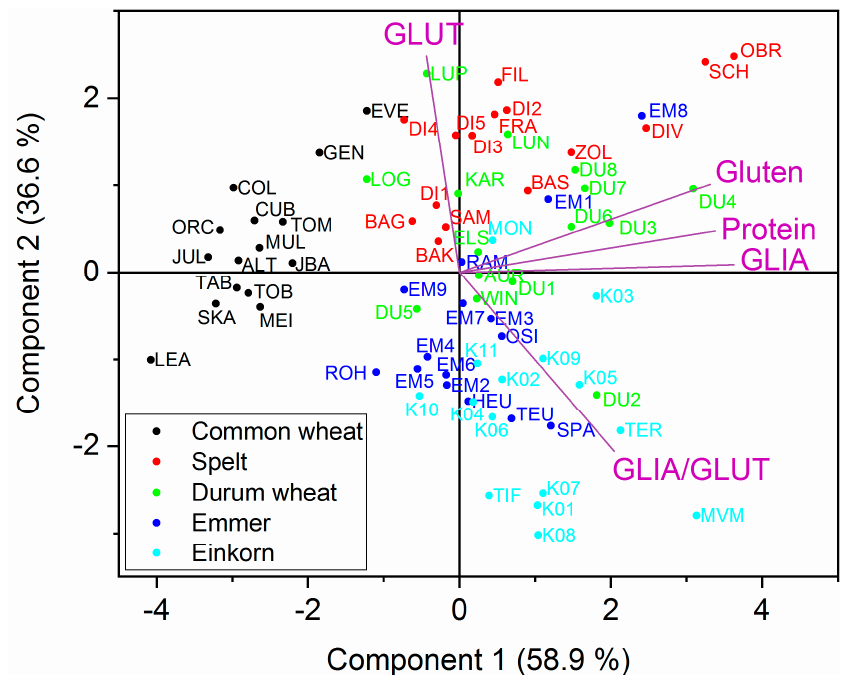
Figure 4. Principal component analysis biplot based on contents of gliadins (GLIA), glutenins (GLUT), gluten and protein, and ratio between gliadins and glutenins (GLIA/GLUT) using the mean value of the four locations. Abbreviations of cultivars can be found in Table S1.